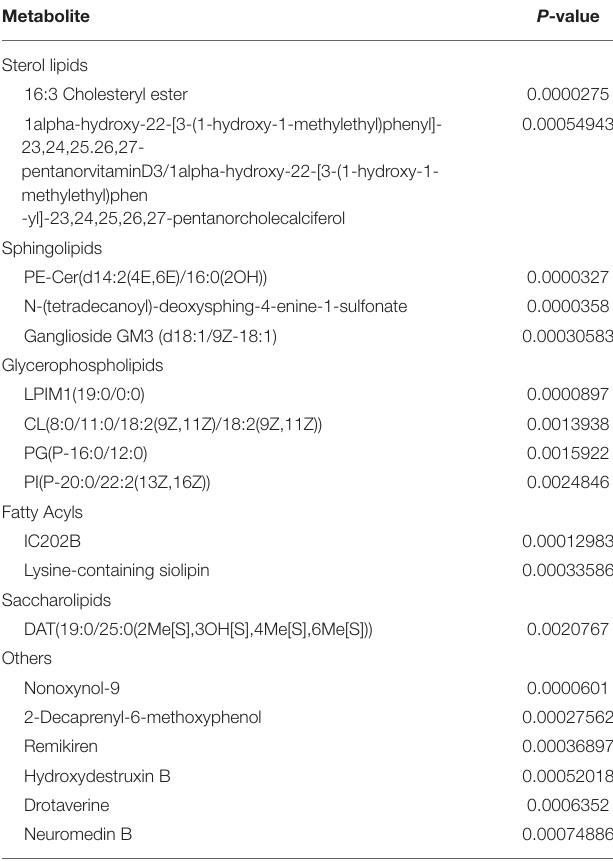
TABLE 3 | The significantly altered metabolites in the comparison of HC and